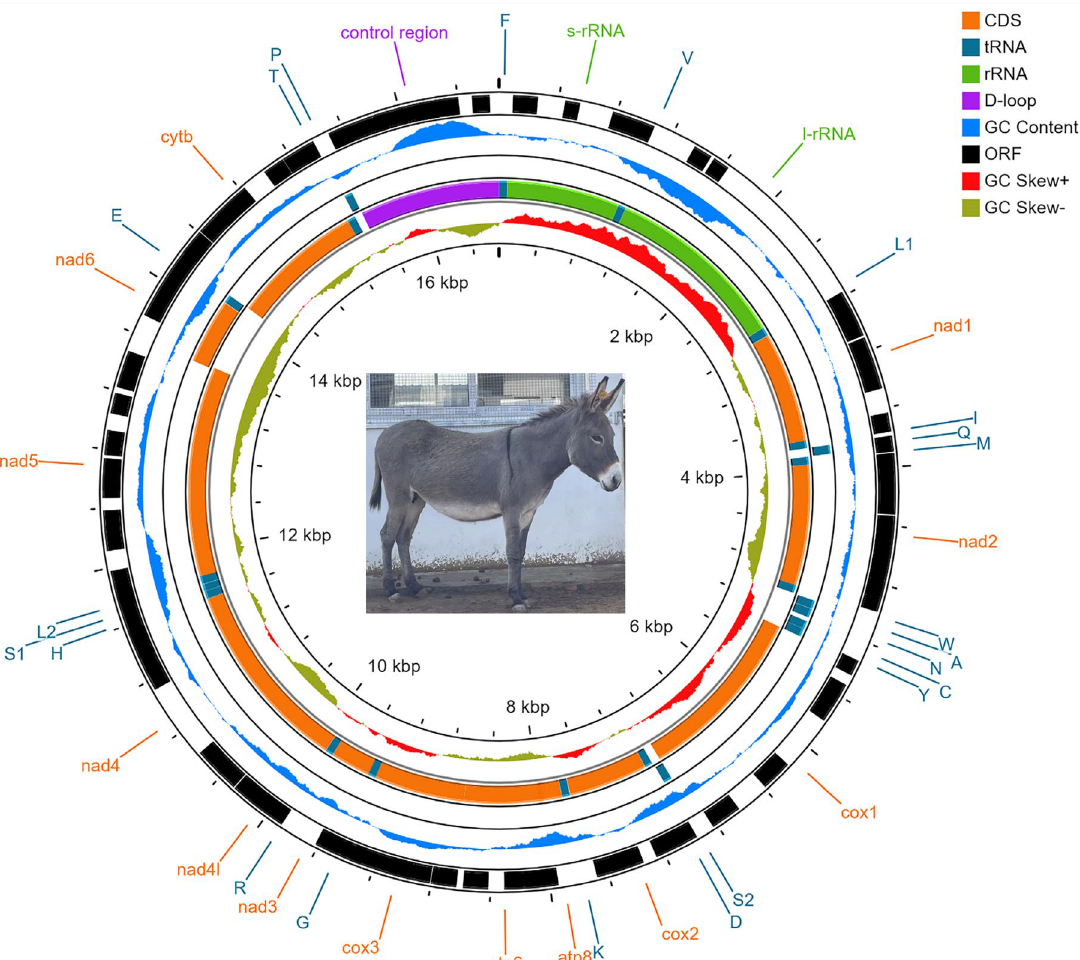
Figure 2. Gene map of the Huaibei grey donkey. Note: W: tRNA-Trp, A: tRNA-Ala, N: tRNA-Asn, Y: tRNA-Tyr, C: tRNA-Cys, D: tRNA-Asp, G: tRNA-Gly, K: tRNA-Lys, R: tRNA-Arg, H: